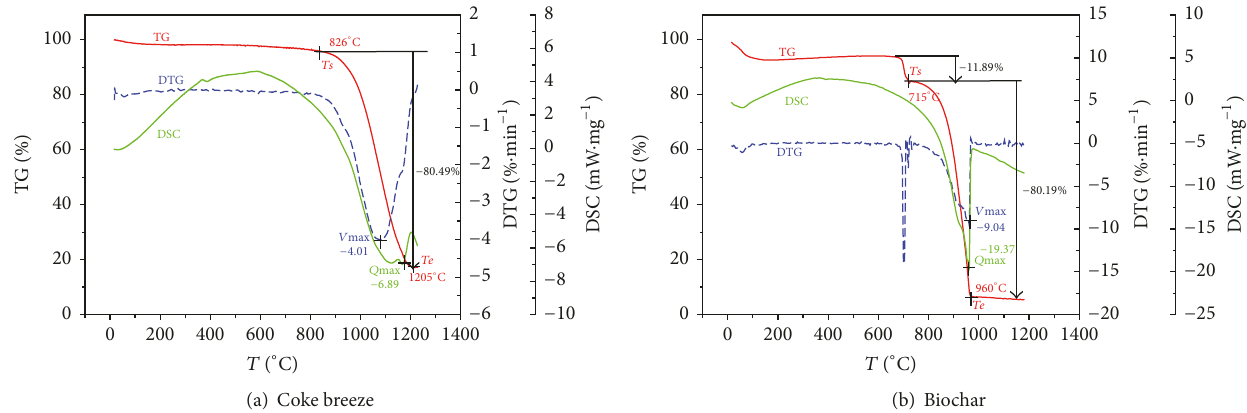
Figure 3: TG-DSC curves of nonisothermal gasification of fuels.